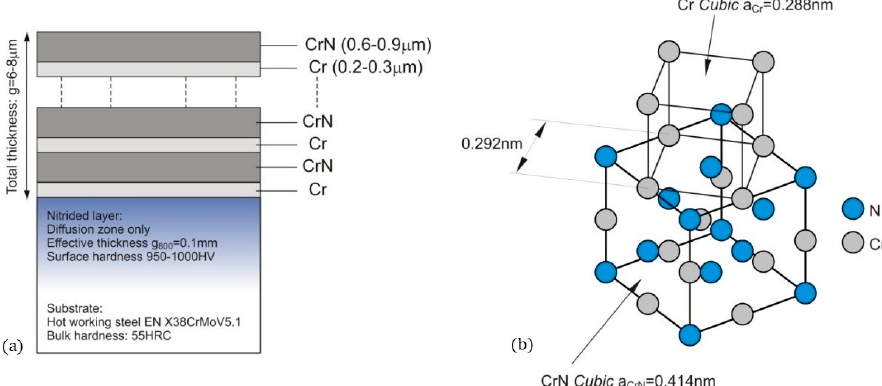
Figure 8. The scheme of the Cr/CrN multilayer coating: ( a ) multi-layered structure, ( b ) crystallographic fit. Reprinted from permission from [15]. Copyright 2007 the Łukasiewicz Research Network—Institute for Sustainable Technology.